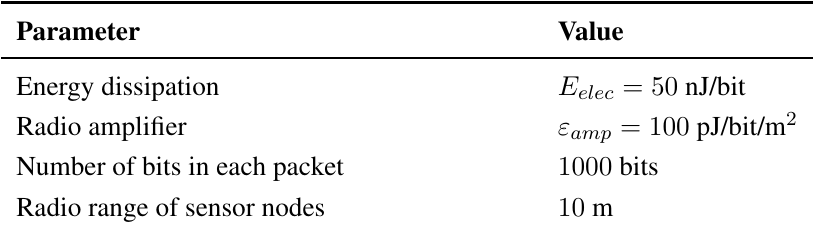
Table 2. Parameters used in the first order radio